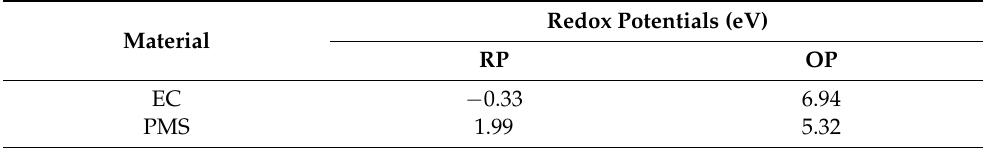
Table 1. The redox potentials of EC and PMS